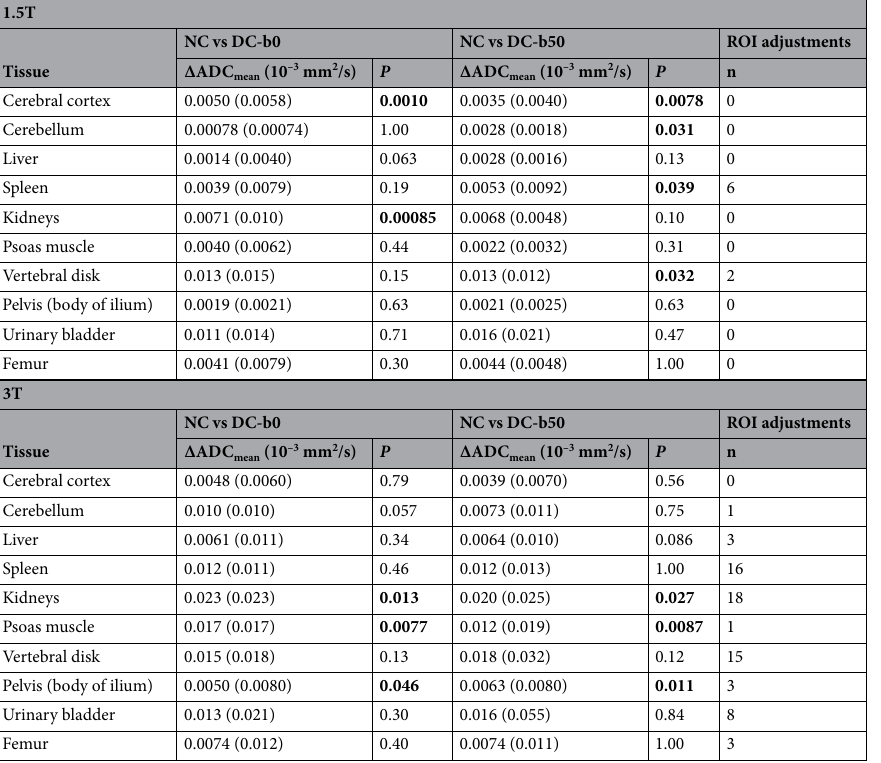
Table 2. Median absolute ΔADC mean measured for selected healthy tissues at 1.5T (top) and 3T (bottom) with the IQR in parentheses. The reported P -values were obtained from paired Wilcoxon signed-rank tests when comparing ADC mean values extracted from NC and DC-b0 data, and from NC and DC-b50 data. Statistical significance is marked in bold ( P < 0.05). The number of ROIs that had to be adjusted for the distortion corrected data is also shown: a total of 6 subjects required ROI adjustments at 1.5T, while all subjects required ROI adjustments at 3T. NC non-corrected, DC-b0 b0-based distortion correction, DC-b50 b50-based distortion correction, ADC mean mean apparent diffusion coefficient, ROI region of